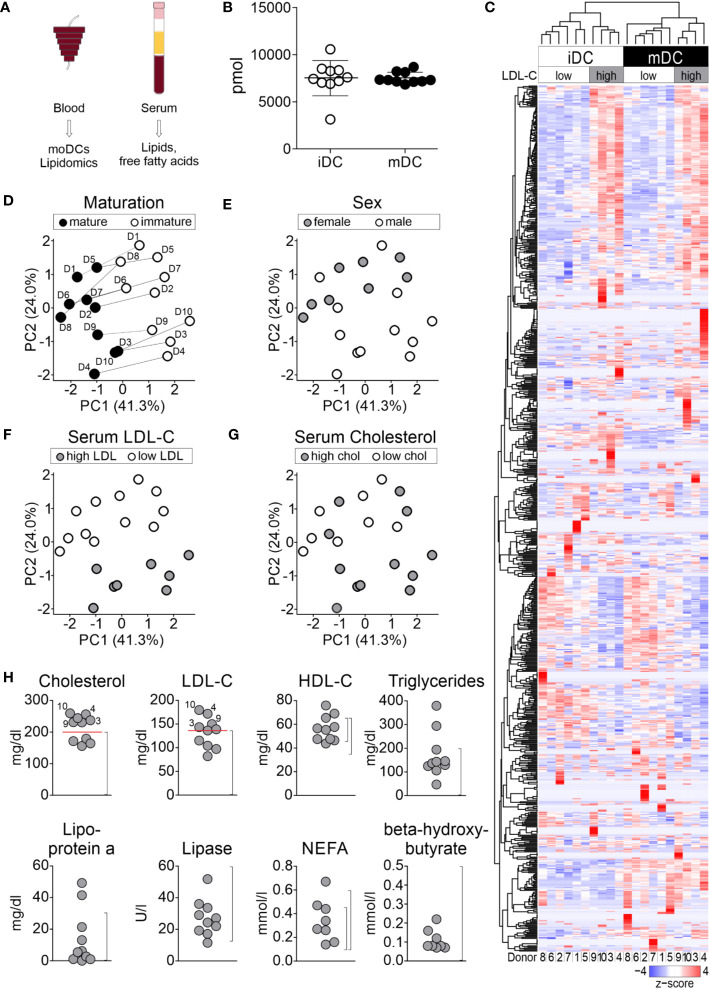
Lipid analyses of moDCs. moDCs were generated as described before. Immature and mature moDCs of ten healthy blood donors were sorted by flow cytometry and shotgun lipidomics analysis of 1.2 × 105 to 2.3 × 105 cells using mass spectrometry was performed by Lipotype Dresden. (A) Workflow for lipid analyses. (B) Global lipid content of immature and mature moDCs of all donors. The total amount of lipids was calculated by summing the pmol values of the individual lipids belonging to each donor. Values represent the mean of ten biological replicates. (C) 830 different lipids were detected, which make up the dendrogram on the left hand side of graph. Each column represents one sample: white indicates immature moDCs, while black depicts mature moDCs. The lipid amounts of cells have been normalized and scaled to a minimum of −4 and maximum of 4. Hierarchical clustering was performed using average linkage, where the distance between clusters has been calculated using Pearson’s correlation coefficient ρ (d=(1-ρ)/2). Principal component analysis (PCA) for identification of (D) maturation, (E) sex, (F) serum LDL-C, and (G) serum cholesterol-dependent lipid composition of moDCs. Lipid species mol% values per sample were used as input data and further analyzed using R software. Shown are the two principal components (PCs) that had the highest contribution to the variance within the data set. PC1: 41.3%, PC2: 24.0%. (H) Analysis of lipids and fatty acids for determination of overall serum lipid profile. Dot plots of serum lipid levels from blood donors for cholesterol (normal rage (NR): <200 mg/dl), low-density lipoprotein (LDL-C, NR: <140 mg/dl), high-density lipoprotein (HDL-C, NR female: 45–65 mg/dl, NR male: 35–65 mg/dl), triglycerides (NR: <200 mg/dl), lipoprotein a (NR: 0–30 mg/dl), lipase (NR: 13–60 U/L), non-esterified amino acids (NEFA, NR female: 0.10–0.45 mmol/L, NR male: 0.10–0.60 mmol/L), and β-hydroxybutyrate (NR: <0.5 mmol/L). Normal ranges for each lipid or fatty acid are indicated in brackets. Analyzed donors n = 10 (same donors as for lipidomics).